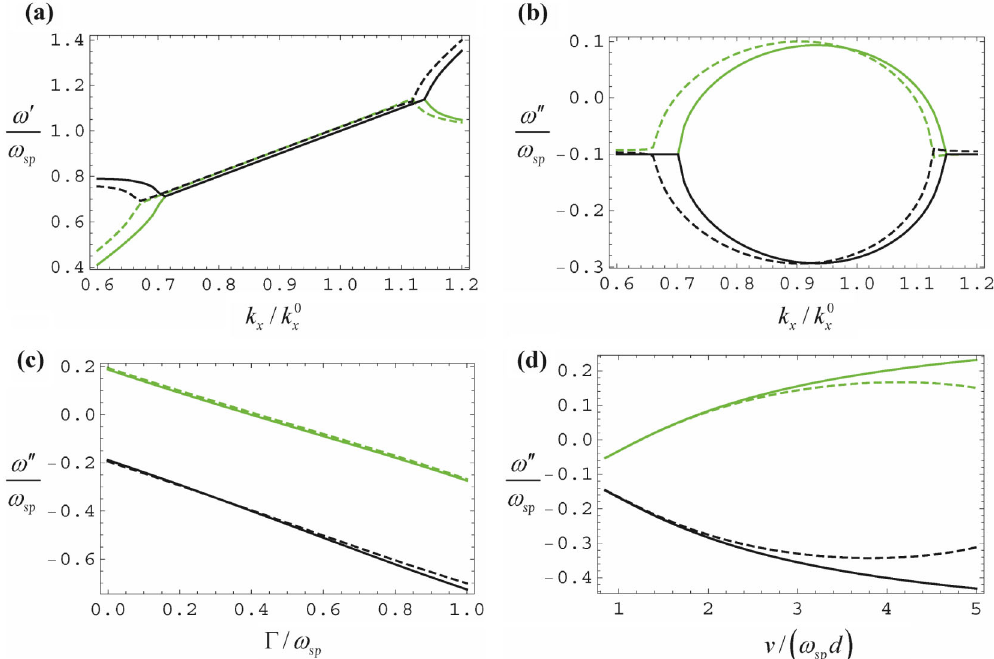
d=c ¼ 0 . 135 ) are in relative motion. (a) Real part and (b) imaginary part of sp for Γ ¼ 0 . 2 ω , and x sp 2 ω =v . (c) Effect of loss: Imaginary part of the natural oscillation x ¼ sp 0 . 9 k 0 . (d) Effect of changing the relative velocity: x x ¼ 2 ω =v and Γ ¼ 0 . 2 ω . In all the x ¼ sp sp